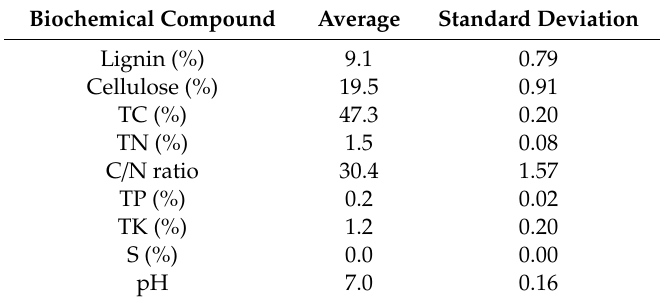
Table 2. Biochemical properties of BGR’s in natural form, prior to inoculation with the strains ( X. feejeensis , X . cf. microceras and T. versicolor ) and their standard deviation based on four replicates. Biochemical Compound Average Standard Deviation Lignin (%) 9.1 0.79 Cellulose (%) 19.5 0.91